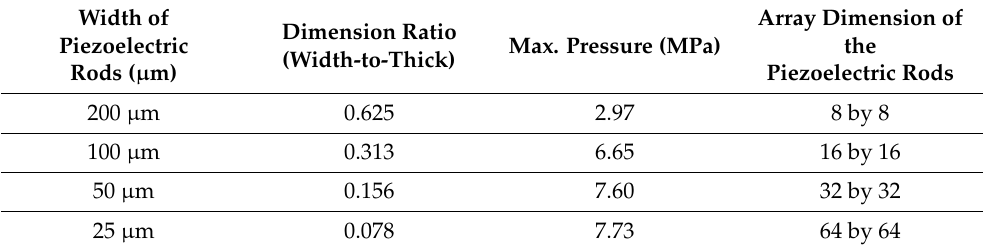
Figure 8. Acoustic pressure output at the focal point with respect to the width of the piezoelectric rods in the 1–3 composite transducer. Table 2. Acoustic pressure output at 5 MHz with respect to the width-to-thickness ratio of the piezoelectric rod in the 1–3 composite transducer.